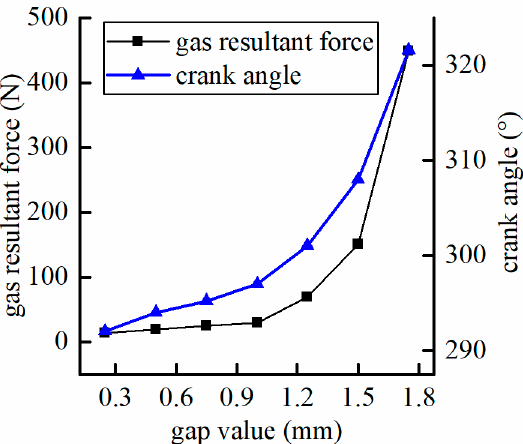
Figure 9. The relation curve of maximum gas resultant force, clearance and crank angle.